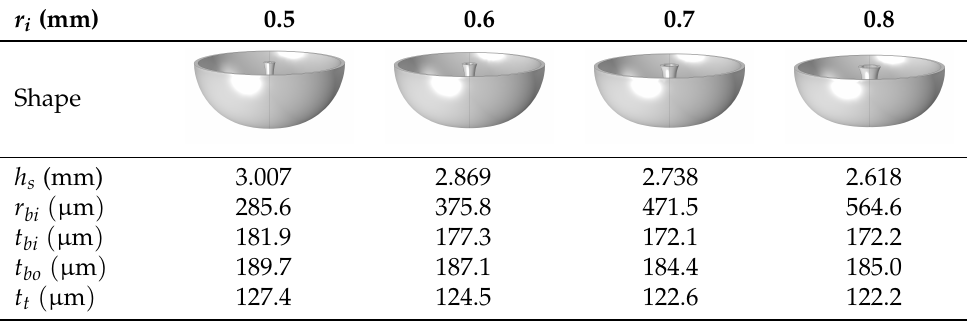
Table 5. Shape and key shape parameters of microhemispherical shells at different groove inner diameters.